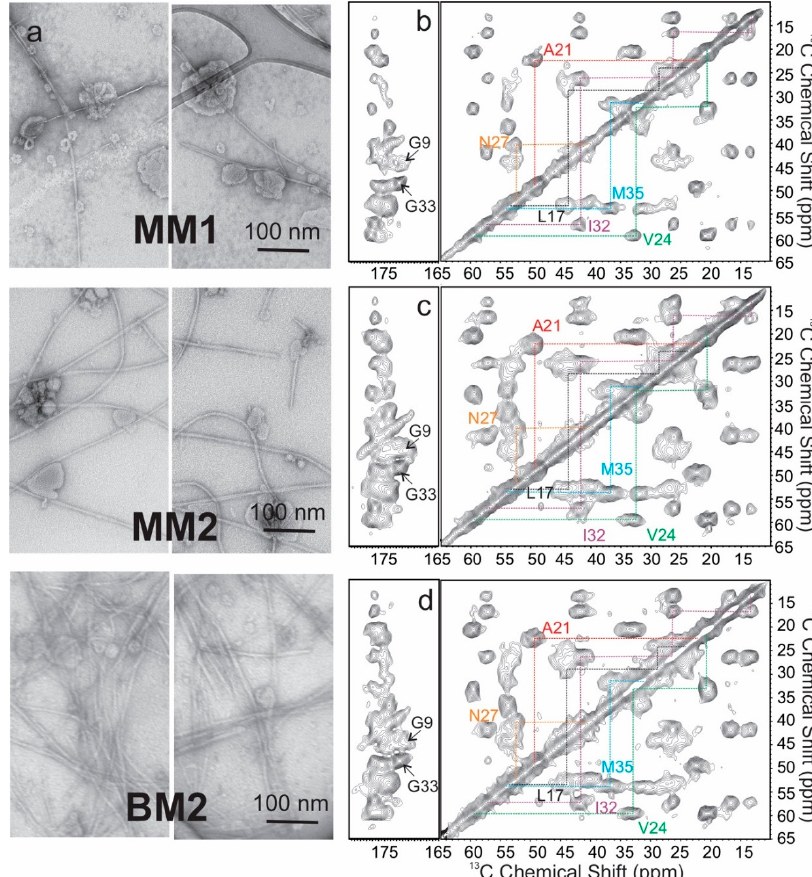
Figure 4. ( a ) Negatively stained transmission electron microscopy (TEM) images for A β 40 fibrils grown in the presence of MM1 (top), MM2 (middle), and BM2 (bottom) model membranes (MM1: the model bilayer with 100% phosphatidylcholine; MM2: the model bilayer with phosphatidylcholine/phosphatidylglycerol/cholesterol/sphingomyelin/ganglioside GM1 at molar ratio 1.00/1.00/1.33/1.00/0.10; BM2: rat synaptic plasma membrane vesicles with 12-month age). ( b – d ) Representative short-mixing (20 ms) 2D 13 C– 13 C spin diffusion spectra for A β 40 fibrils formed with ( b ) MM1, ( c ) MM2, and ( d ) BM2 membrane models. The peptides were selectively uniformly labeled at residues G9, L17, A21, V24, N27, I32, G33, and M35. Table 3. Residue-specific 13 C chemical shifts for membrane-associated A β 40 fibrils. MM1